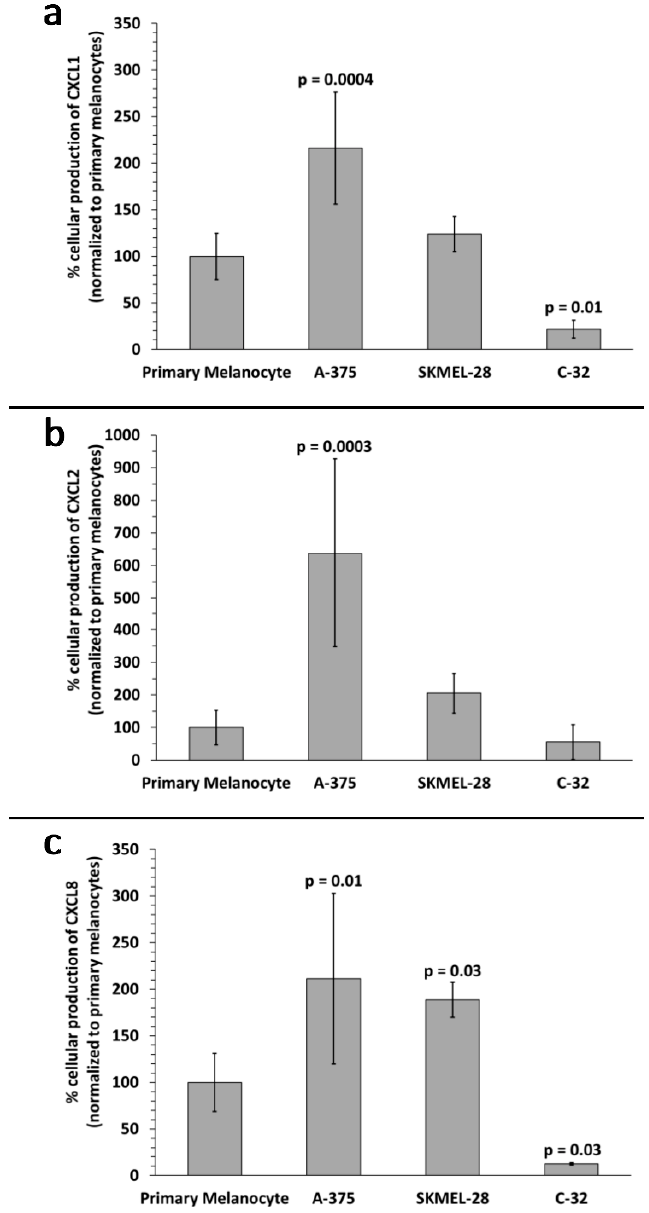
Figure 7. Melanoma cell versus primary melanocyte production of chemokine proteins. Percent protein production levels for ( a ) CXCL1, ( b ) CXCL2, and ( c ) CXCL8 by A-375, SKMEL-28, and C-32 melanoma cells compared to primary melanocytes (control, normalized to 100%) are shown. Data bars represent the average of ( n = 4) independent experiments, error bars = SD, p values <0.05 were considered statistically significant.